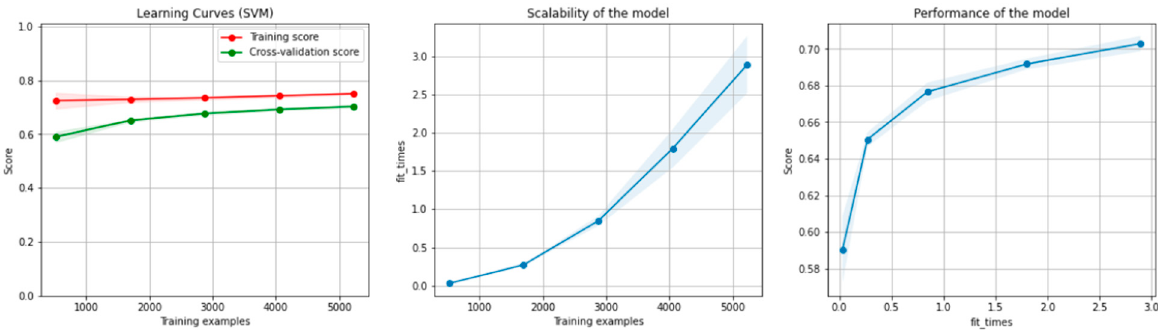
Figure 12. Learning curves, model scalability and model performance for the SVM algorithm, for the overlapping dataset.